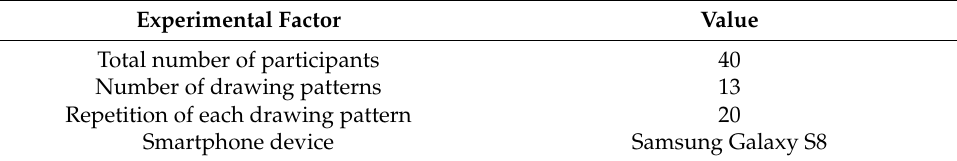
Figure 1. Android application-based data collector. Menus in the guideline in Korean is some supportive information when collecting keystroke data from each participant. Table 1. Experimental environment.